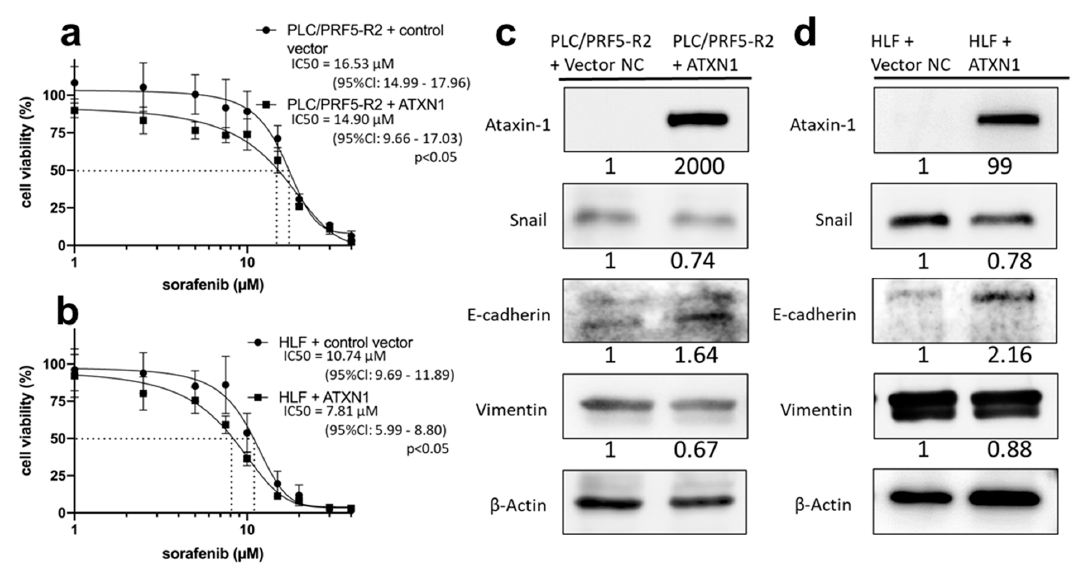
Figure 7. Forced expression of ATXN1 gene reduces sorafenib resistance and MET in PLC/PRF5-R2 and HLF cells. ( a , b ) PLC/PRF5-R2 and HLF cells were transfected with ATXN1 expressing vector (PLC/PRF5-R2-ATXN1, HLF-ATXN1) or the control vector (PLC/PRF5-R2-Vector NC, HLF-Vector NC). They were exposed to sorafenib, and cell viability was assessed by WST assay. ( c , d ) Expression of ATXN1 and EMT markers (E-cadherin, Snail, vimentin) were examined by western blot analysis. Densitometry analysis indicates relative protein levels from one representative of three independent experiments. Numbers below the bands represent protein expression normalized to β -actin.